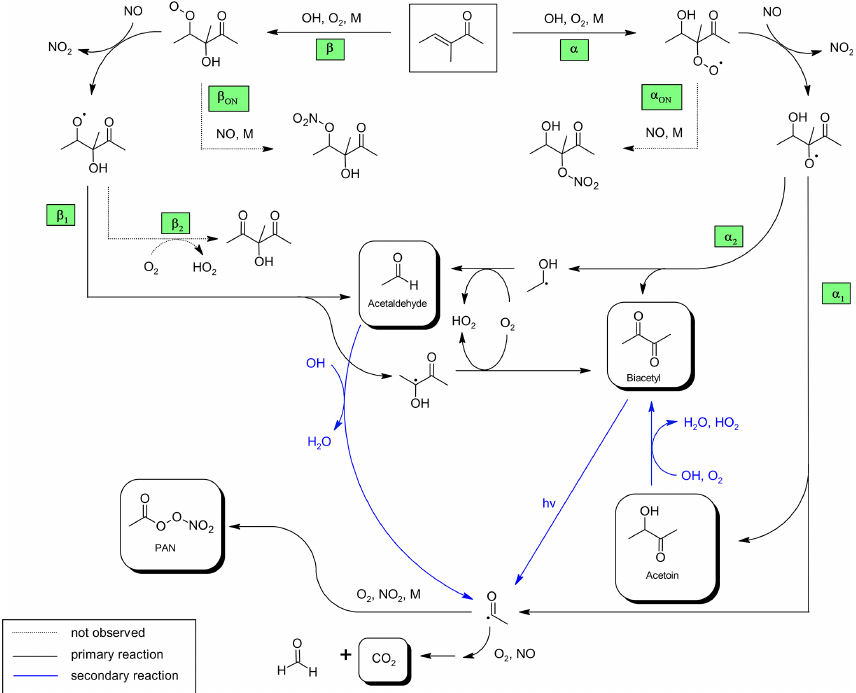
Figure 3. Proposed mechanism for the OH-radical-initiated oxidation of 3-methyl-3-penten-2-one and further oxidation of the first-generation products relevant under the experimental